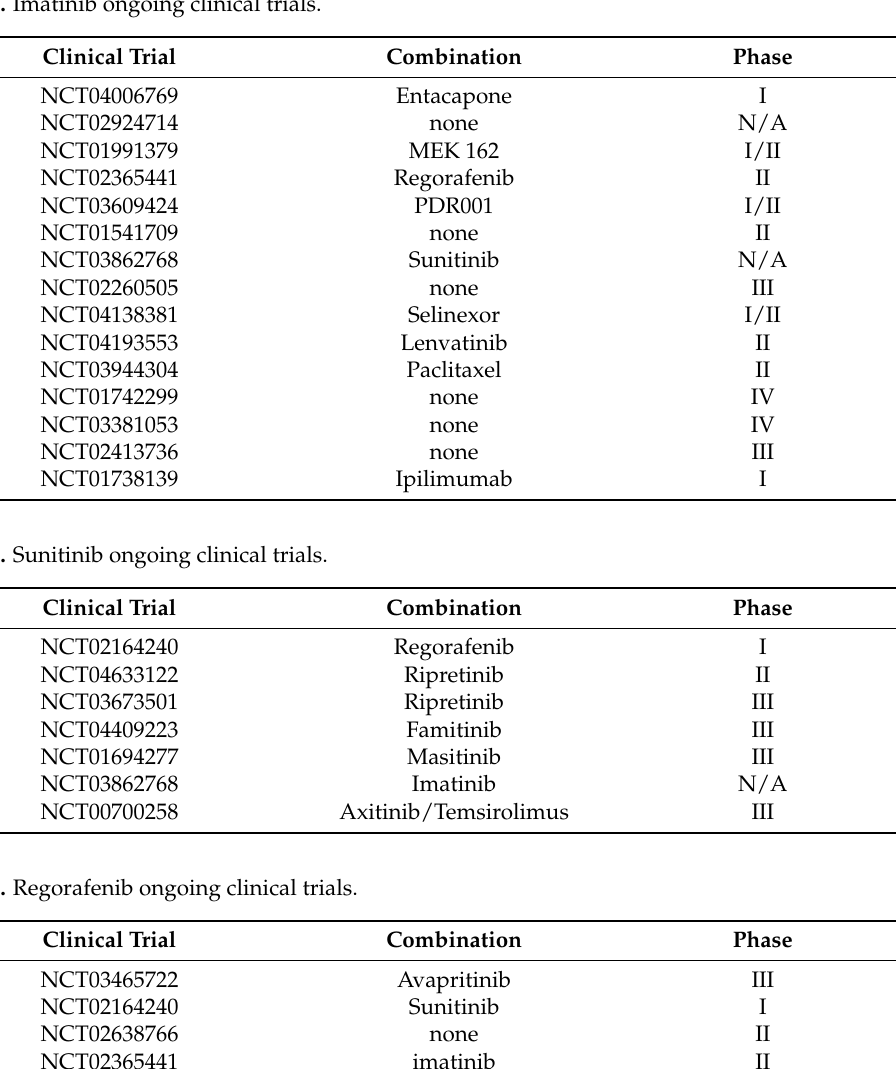
Table 3. Imatinib ongoing clinical trials.